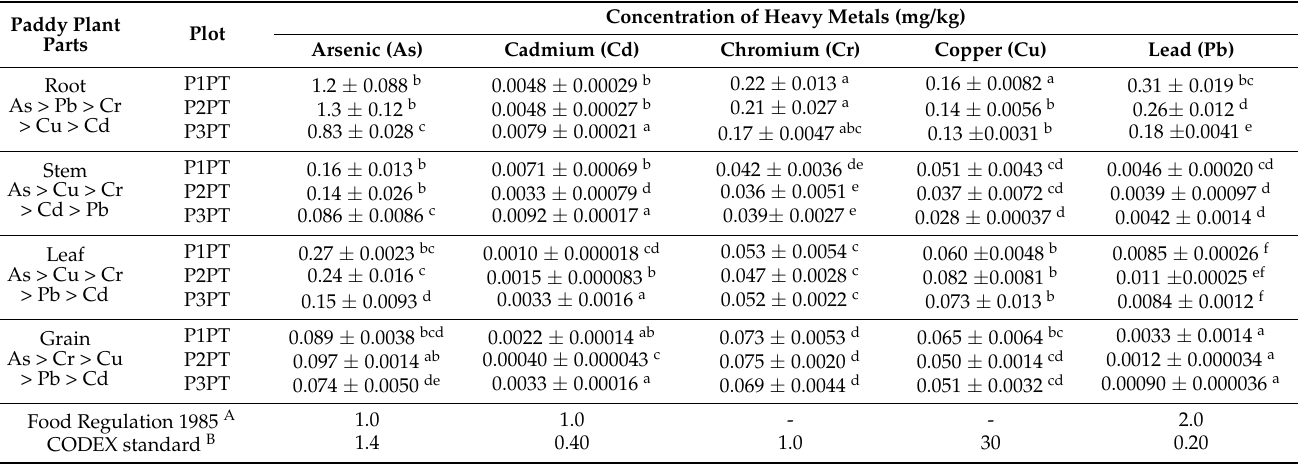
Table 3. Concentration of heavy metals in paddy plants collected from Perak Tengah.